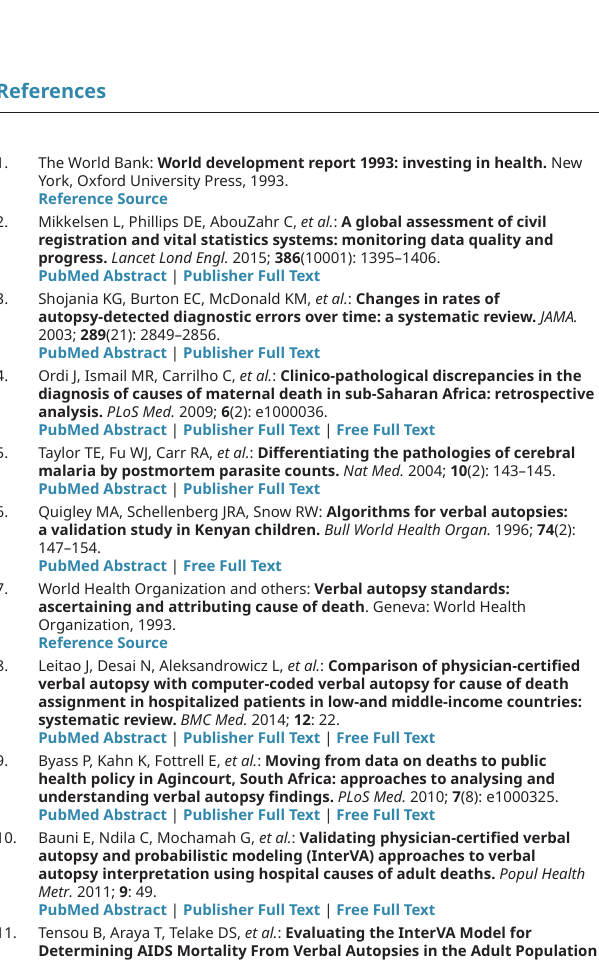
Figure S1. Outline of statistical methods Table S1. Description of metrics Table S2. Study group and number of causes of death and their associated likelihoods as established by the InterVA method